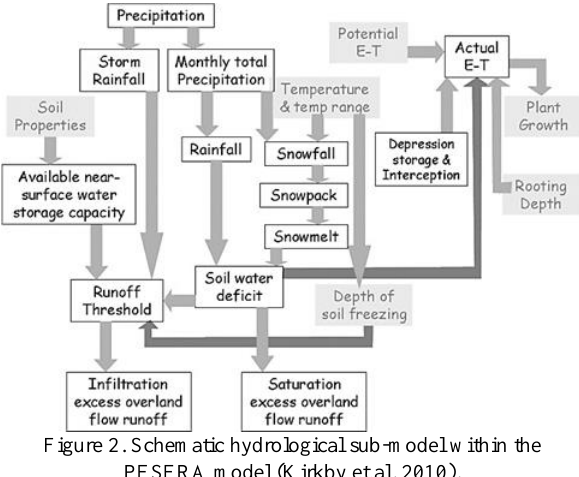
Figure 2. Schematic hydrological sub-model within the PESERA model (Kirkby et al. 2010).